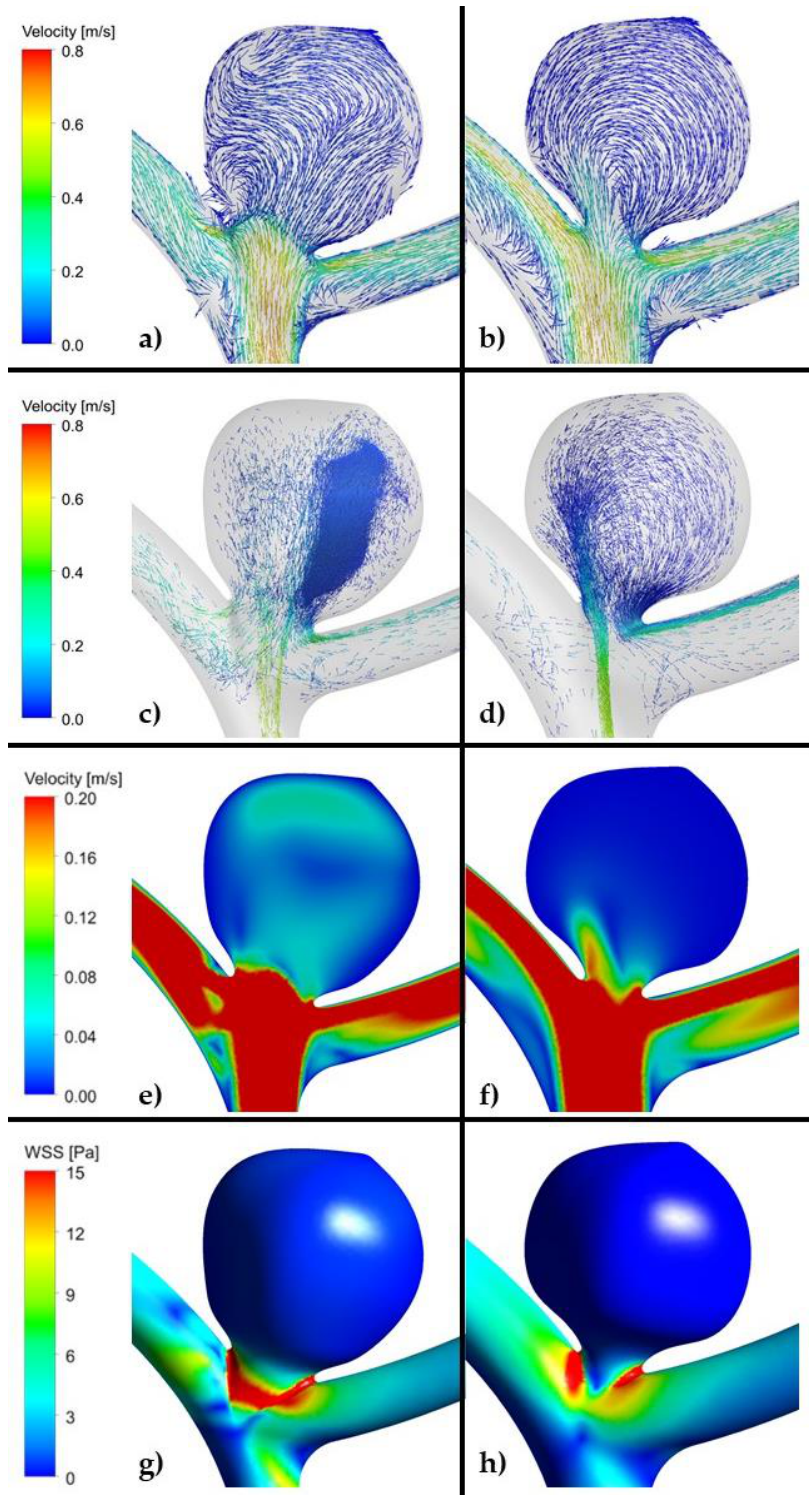
Figure 6. ( a , c , e , g ). Example of high risk recanalization aneurysm model (ruptured group). Flow pattern analysis demonstrates a complex vortex structure. WSS analysis demonstrates heterogenous wall shear stress with an area of the aneurysm dome under high shear stress. ( b , d , f , h ). Example of low risk recanalization aneurysm model (ruptured group). Flow pattern analysis demonstrates a simple vortex structure. WSS analysis demonstrates heterogenous wall shear stress with an area of the aneurysm dome under low shear stress. (ANSYS Inc. Post-processing module, Canonsburg, PA, USA ).